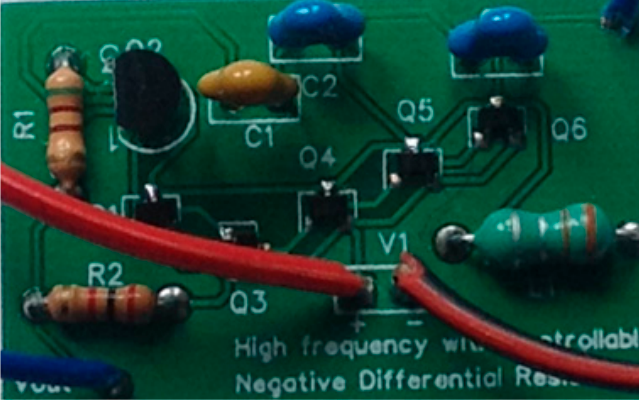
Figure 8. Photograph of the NDR oscillator printed circuit board assembly.